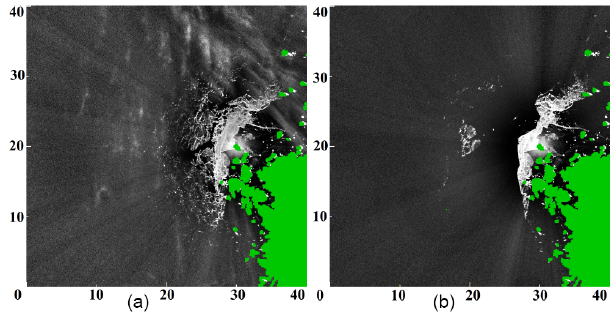
Figure 6. The initial VBs of the February 2011 test data set (a) , and the February 2012 data set (b) drawn over the first radar images of the sequences. The coordinates are in kilometres, and the radar is located at (row, column) = ( 20 , 30 ) . The land area according to our rough land mask is indicated in green. The associated scale is in kilometres.